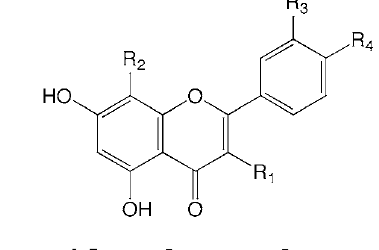
Table 2. Flavone aglycones.